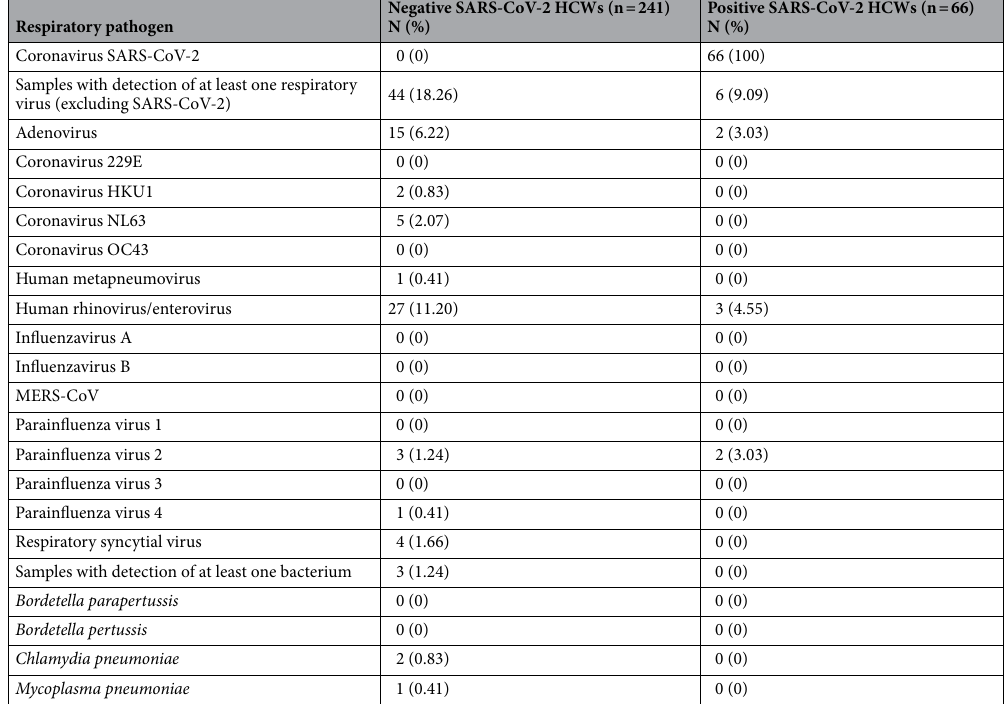
Table 2. Investigation of respiratory pathogens in nasopharyngeal samples from symptomatic healthcare workers (HCWs) using the BioFire Respiratory Panel 2.1 plus. No significant statistical difference ( p -value > 0.05) was observed between samples tested negative or positive by SARS-CoV-2 RT-PCR.